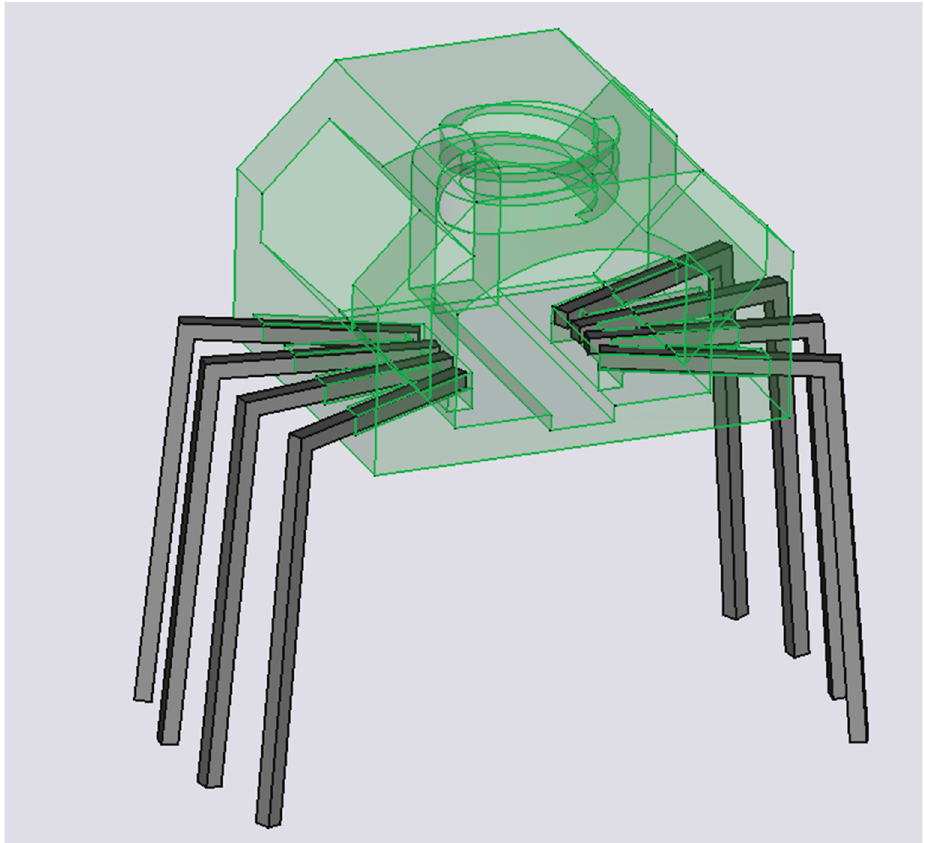
Figure 8. Partially assembled CAD for the device with a semi-translucent enclosure part.